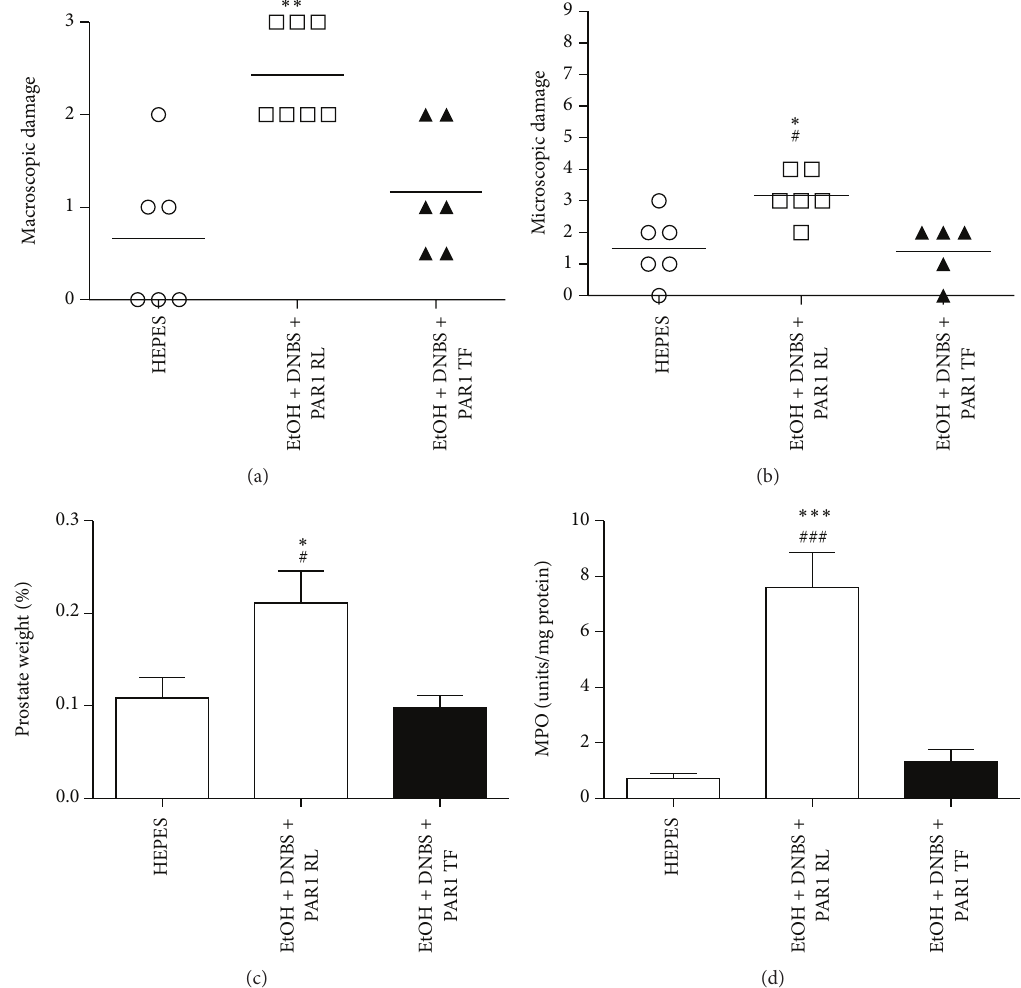
Figure 5: Instillation of the PAR1 activating peptide TFLLR-NH 2 diminishes ethanol- + dinitrobenzene sulfonic acid-induced prostatitis in wild-type mice. Prostates were treated with HEPES vehicle (HEPES), ethanol + dinitrobenzene sulfonic acid + PAR1 reverse peptide RLLFT- NH 2 (EtOH + DNBS + PAR1 RL), or ethanol + dinitrobenzene sulfonic acid + PAR1 activating peptide TFLLR-NH 2 (EtOH + DNBS + PAR-1 TF) for 2 days. The inflammatory response was measured by monitoring (a) macroscopic prostate damage, (b) microscopic prostate damage, (c) percent prostate weight, and (d) myeloperoxidase (MPO) activity. Data are mean ± SEM of 𝑛 = 5-6 per group. ∗ 𝑃 < 0.05 , ∗∗ 𝑃 < 0.01 , and ∗∗∗ 𝑃 < 0.001 for EtOH + DNBS + PAR1 RL versus HEPES; # 𝑃 < 0.05 , ### 𝑃 < 0.001 for EtOH + DNBS + PAR1 RL versus EtOH + DNBS + PAR1